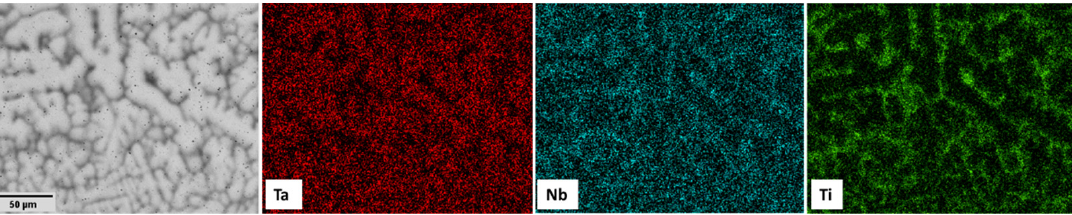
Figure 3. ( a ) XRD pattern of the Ta-Nb-Ti alloy in the as-cast condition. ( b ) SEM backscattered electron (BSE) image of the alloy Ta-Nb-Ti.